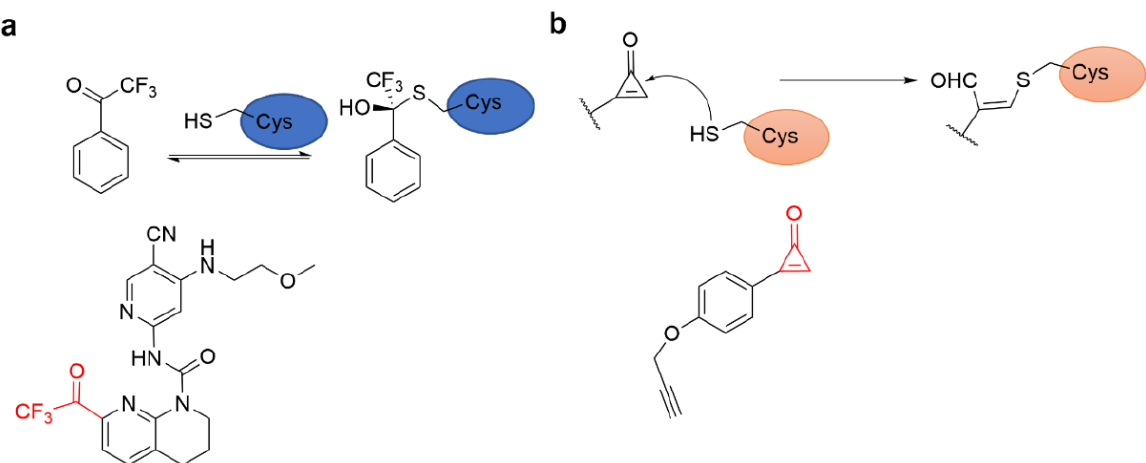
Figure 13. ( a ) The mechanism of reversible covalent adduct formation of aromatic trifluoromethyl ketones with cysteine residues and the chemical structure of an aryl trifluoromethyl ketone-based covalent reversible inhibitor of FGFR4 kinase. ( b ) The reaction mechanism of cyclopropenone with thiol groups and GSTP1 inhibitor with cyclopropenone warhead.